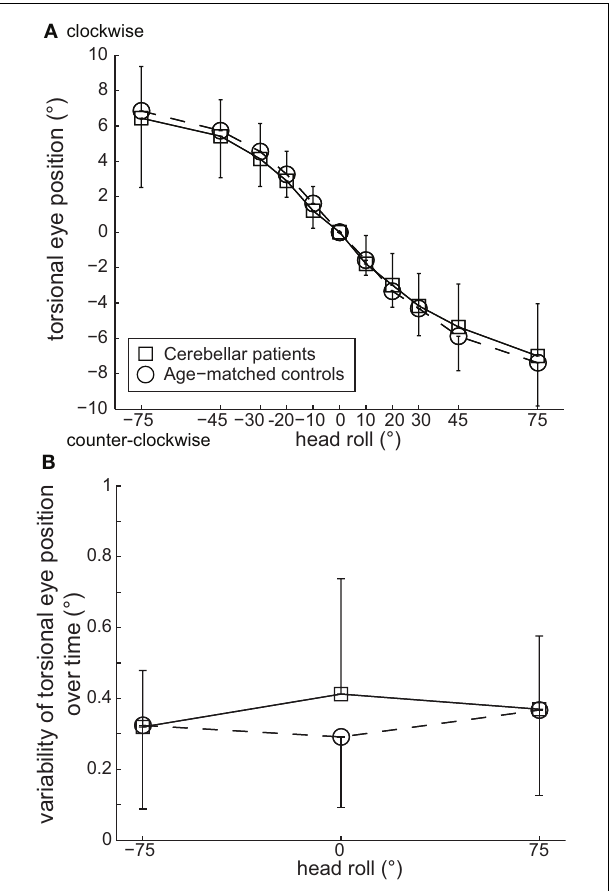
FIGURE 2 | (A) Means of static torsional eye position ( ± 1 SD) in 75˚, 45˚, 30˚, 20˚, and 10˚ whole-body roll tilt positions to either side (positive values corresponding to right-ear-down positions, i.e., clockwise roll tilts, as seen from the subject) did not differ significantly ( p > 0.05) between patients (squares) and age-matched controls (circles). (B) Variability of static torsional eye position over time (10s) in upright and 75˚ right- (positive values) and left-ear-down (negative values) positions to either side was not significantly different ( p > 0.05) between patients (squares) and age-matched controls